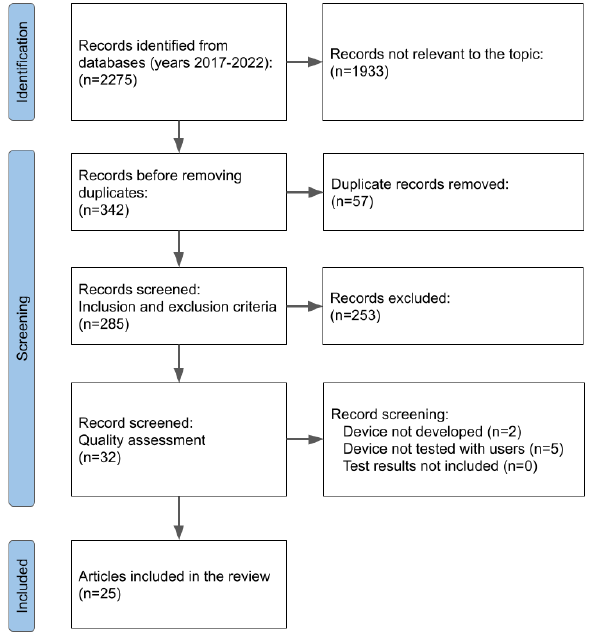
Figure 1. PRISMA flow diagram for the review process displaying the number of excluded papers for each